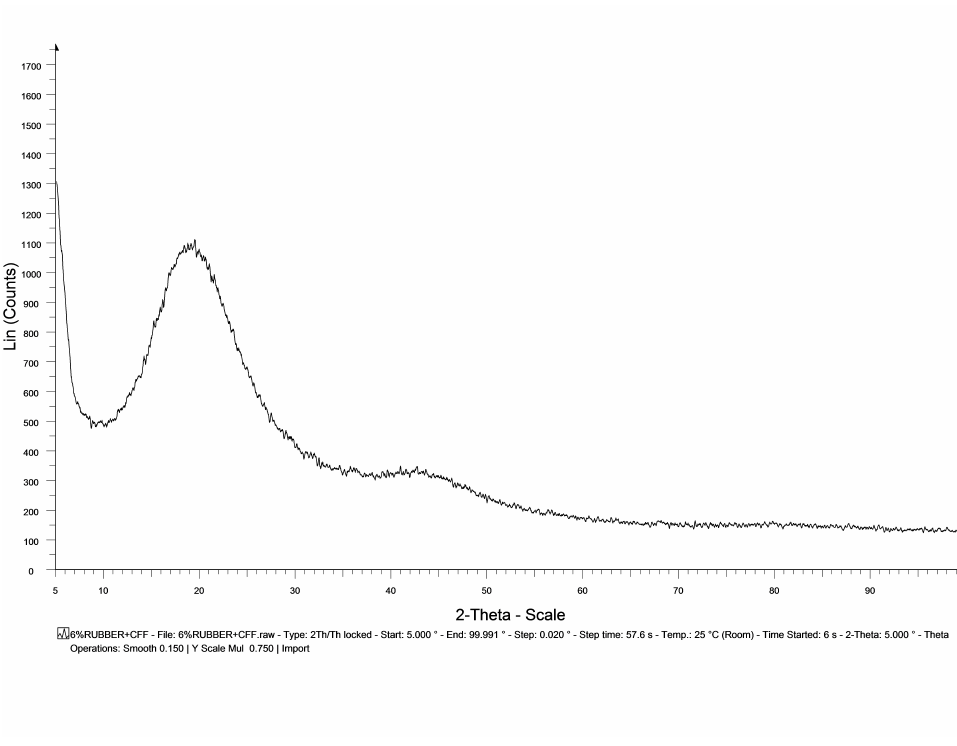
Figure 32: XRD for the sample containing 2.5 wt% CR and 5.0 wt%